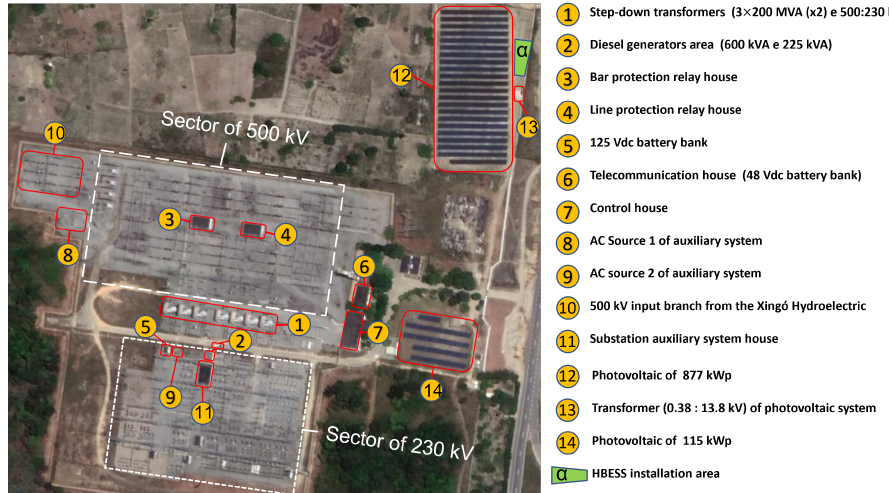
Figure 1. Real view of high voltage SS and indication of the HBESS installation